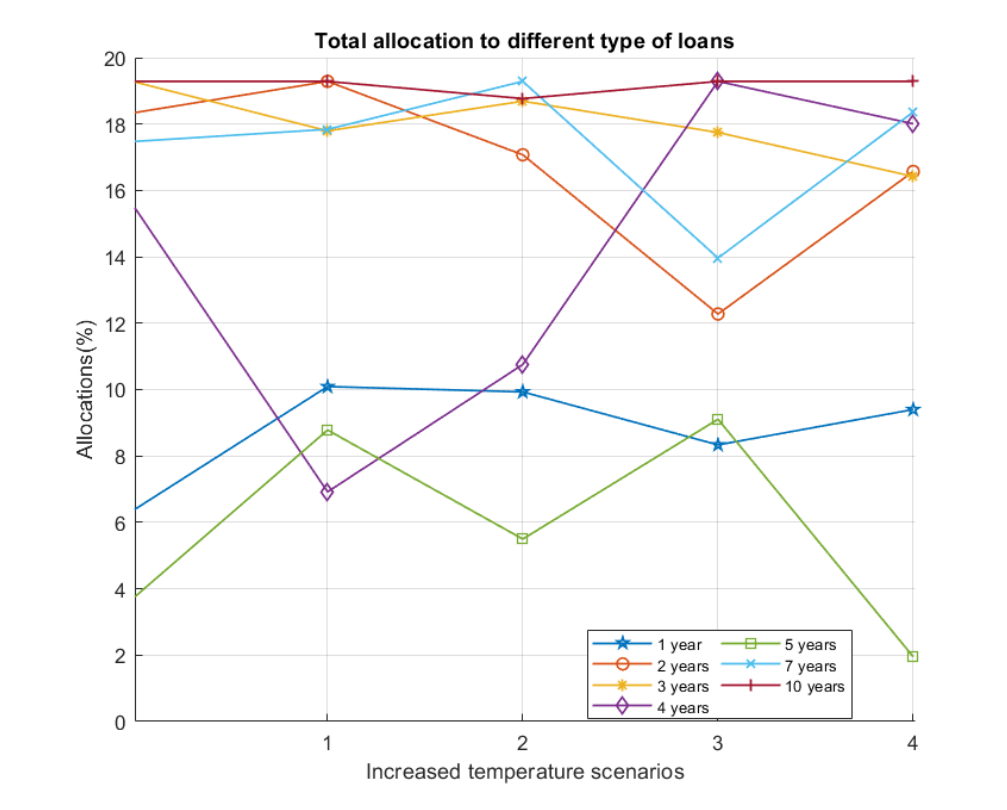
Figure 4. Allocations to each tenor of loan under five different 1 ◦ C increased temperature